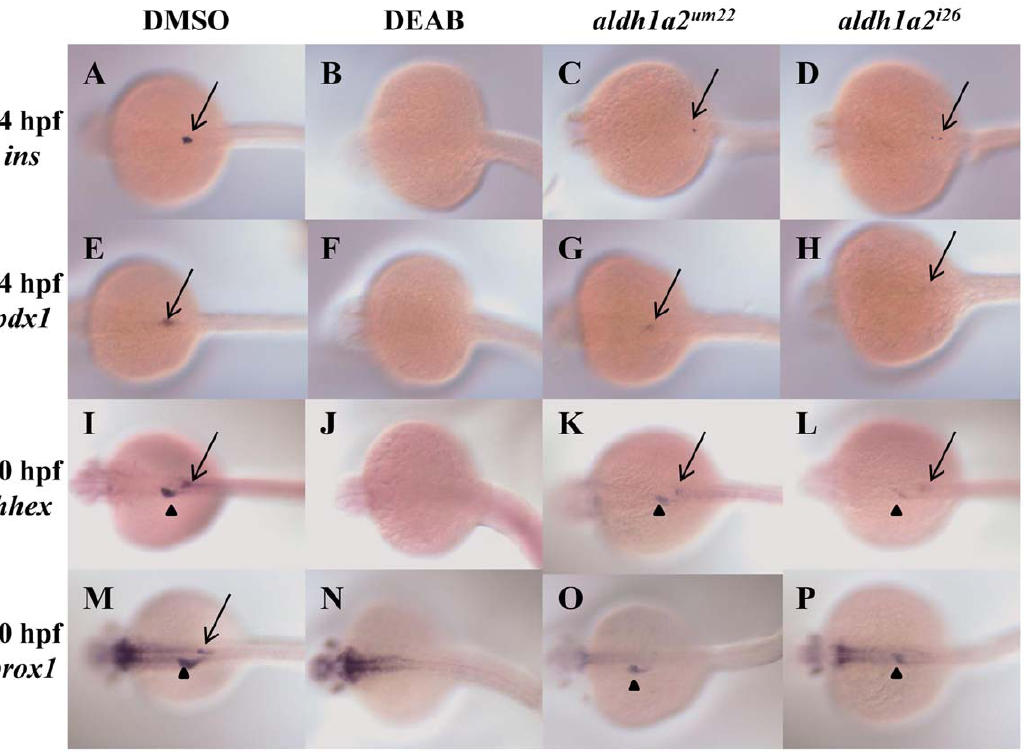
Figure 3. aldh1a2 um22 and aldh1a2 i26 mutant embryos retain some endoderm gene expression at 24 and 30 hpf. DMSO treated wild type embryos (A, E, I, M), DEAB-treated wild type embryos (B, F, J, N), embryos from an incross of aldh1a2 um22 heterozygotes (C, G, K, O) and embryos from an incross of aldh1a2 i26 heterozygotes (D, H, L, P) were assayed for expression of ins at 24 hpf (A–D; black arrows indicate residual expression), pdx1 at 24 hpf (E–H; black arrows indicate residual expression), hhex at 30 hpf (I–L; residual expression is indicated in pancreas (arrow) and liver (arrowhead)) and prox1 at 30 hpf (M–P; residual expression is indicated in liver (arrowhead)). Embryos are in dorsal view with anterior to the left. See Table 2 for